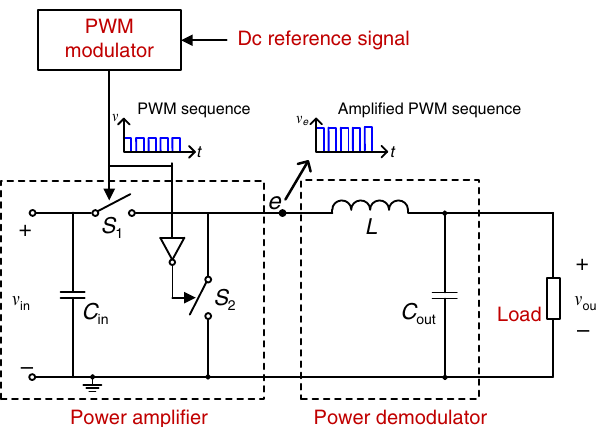
Fig. 2 Structure of a buck/boost converter. S 1 and S 2 are two identical metal-oxide-semiconductor fi eld-effect transistors (MOSFETs) as ideal switches, C in denotes the input capacitor and C out denote the output capacitor. L denotes the inductor. v in and v out are input and output voltages, respectively. The buck/boost converter can be divided into fi ve components, as labelled in red: a dc reference signal, a PWM modulator, a power ampli fi er, a power demodulator, and a load. The power ampli fi er includes an input dc source and two switches operating in a complementary mode. The power demodulator includes an LC LPF. The waveform at point ‘ e ’ is the ampli fi ed PWM